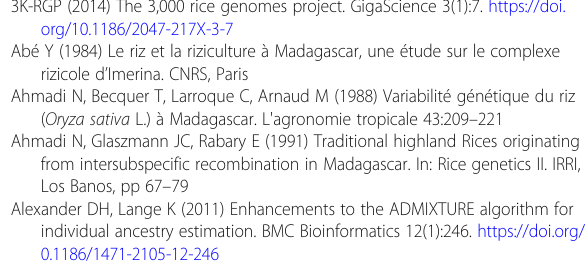
Additional file 1: Supplementary Figure S1 : Heat map of distribution of the two set SNP loci (32,614 and 23,981) along the genome. Additional file 2: Supplementary Figure S2 : Population structure in 1929 accessions of the Asian panel estimated from 23,981 genome wide SNPs. The subpopulations are coloured according to their membership to groups defined by Wang et al. (2018). Additional file 3: Supplementary Figure S3: Altitudinal distribution of the Malagasy panel 620 rice accessions according to their membership to groups defined by the sNMF-based analysis of population structure. Additional file 4: Supplementary Figure S4 : Unweighted neighbour- joining tree of simple matching distances, constructed with the geno- typic data of individual chromosomes (C1 to C12). Accessions of the Asian panel are coloured according to their membership to subpopula- tions defined by Wang et al. (2018). Accessions of the Malagasy panel are coloured according to their membership to sNMF groups at K=3 and an- cestry coefficient threshold of 0.8. Positions of the Malagasy accessions on the trees are highlighted with coloured arrows corresponding to their group membership. Accessions of the Asian panel are coloured according to their membership to major populations defined by Wang et al. (2018). Additional file 5: Supplementary Figure S5 : Unweighted neighbour- joining tree of simple matching distances, constructed with the geno- typic data at 11.6 – 15.7 Mb segment of chromosome 11 (225 SNP). Ac- cessions of the Asian panel are coloured according to their membership to major populations defined by Wang et al. (2018). Accessions of the Malagasy panel are coloured according to their membership to sNMF groups at K = 3 and ancestry coefficient threshold of 0.8. Additional file 6: Supplementary Figure S6 : Unweighted neighbour- joining tree of simple matching distances, constructed with the geno- typic data at 10.9 – 16.3 Mb segment of chromosome 8 (221 SNP). Acces- sions of the Asian panel are coloured according to their membership to major populations defined by Wang et al. (2018). Accessions of the Mala- gasy panel are coloured according to their membership to sNMF groups at K = 3 and ancestry coefficient threshold of 0.8. Additional file 7: Supplementary Table S1 : List and main characteristics of the 620 Malagasy rice accessions used in the present study. Additional file 8: Supplementary Table S2 : List of the 3K-RG project accessions used in the present